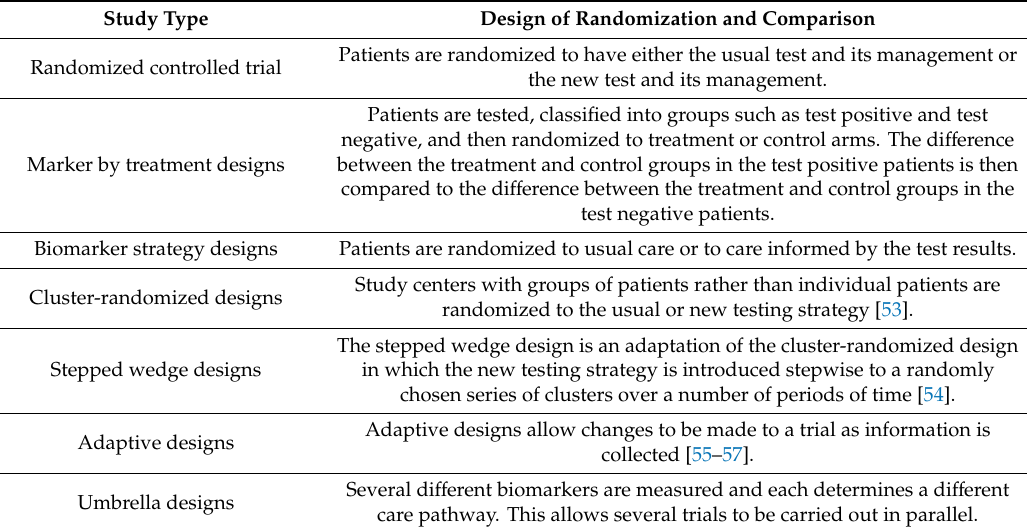
Table 4. Types of randomized controlled trials that can be used to evaluate a diagnostic test. Each of the basic designs has a number of